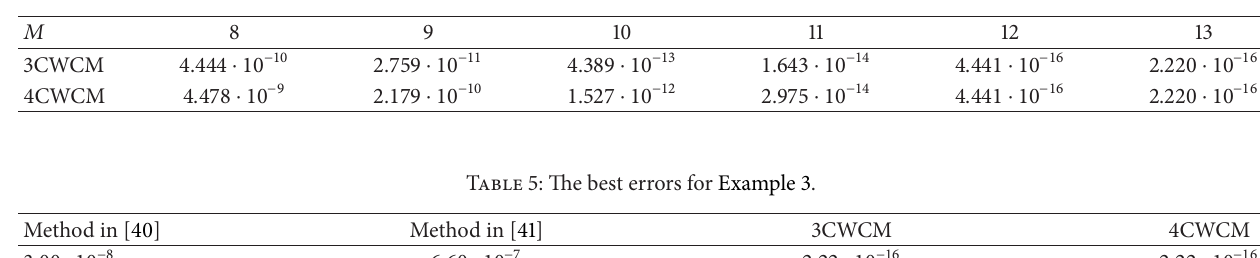
Table 4: The maximum absolute error 𝐸 for Example 3.